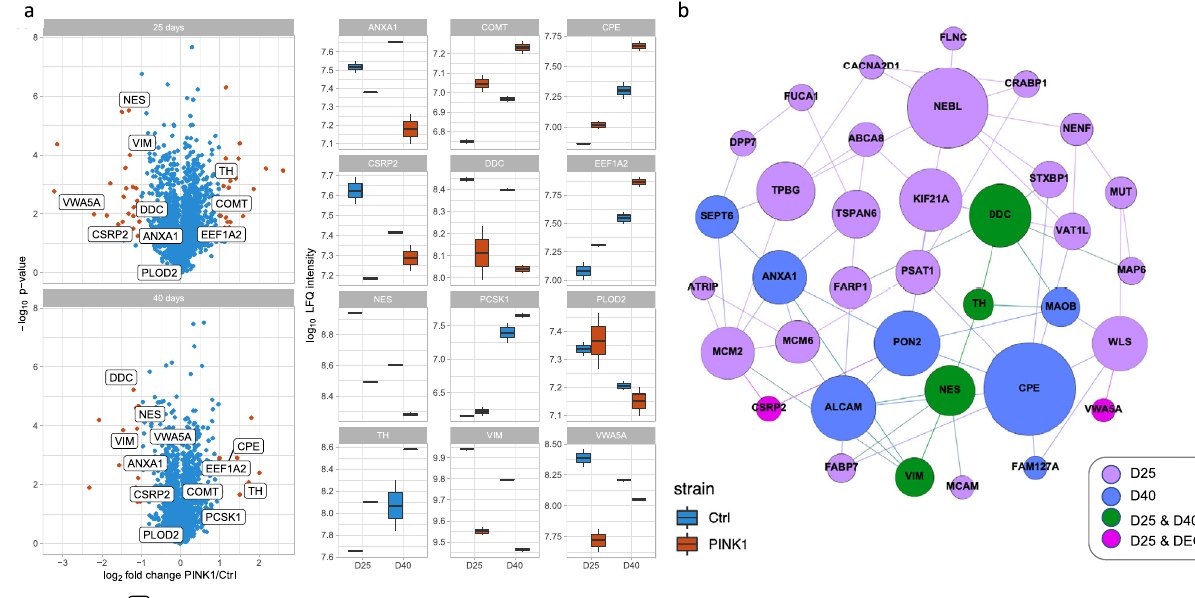
Fig. 7 Comparative proteomics analysis between CTRL and PINK1 -ILE368ASN cell line at D25 and D40 validates the manifestation of the transcriptional phenotype. Results of proteomic analysis at D25 and D40 of the differentiation protocol. a The volcano plot shows signi fi cantly differentially abundant proteins (FDR <0.05, fold change larger than 2 or − 2) as red points, with remaining datapoints shown in blue. The names of proteins that were detected as both top differentially abundant at the protein level by the proteomics analysis and as differentially expressed at the mRNA level by SC-RNAseq are highlighted using a textbox. The data shows results at two timepoints, D25 and D40, in two biological replicates per timepoint. Box plots further highlight the expression of genes shown in textboxes of the volcano plot (interquartile range, showing the expression at D25 and D40, in the PINK1 cell line and in control (IQR, 25 – 75% q1 – q3), with bars indicating Q1 ± 1.5 IQR). b This fi gure shows a network of proteins differentially expressed between a control and a PINK1 mutation-carrying cell line, at D25 and D40. Proteins which are differentially expressed at both D25 and D40 are highlighted in green and point to a dysfunction of the dopaminergic system. D25 differentially abundant proteins are in purple, D40 in blue, proteins also identi fi ed as by SC-RNAseq differentially expressed at the mRNA level are in pink. For a table of proteins see Supplementary Table 8. Betweenness centrality was used to illustrate the relative connectedness of each node within the network, the greater the number of documented interactions with other nodes, the larger the